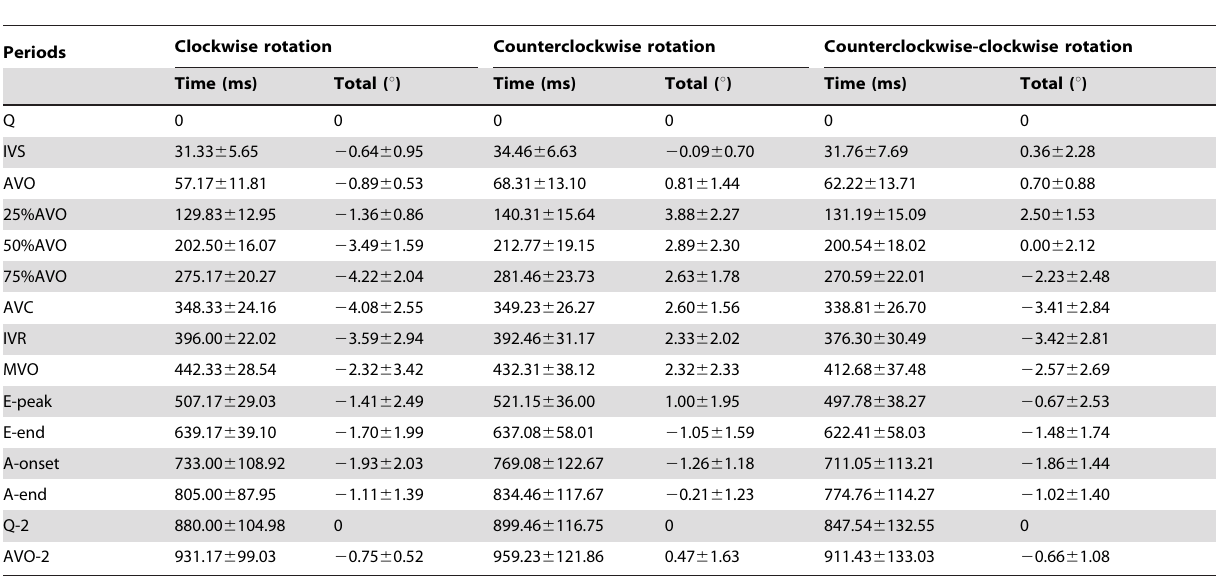
Table 2. Three rotation patterns at the papillary muscle short-axis levels (mean 6 SD).